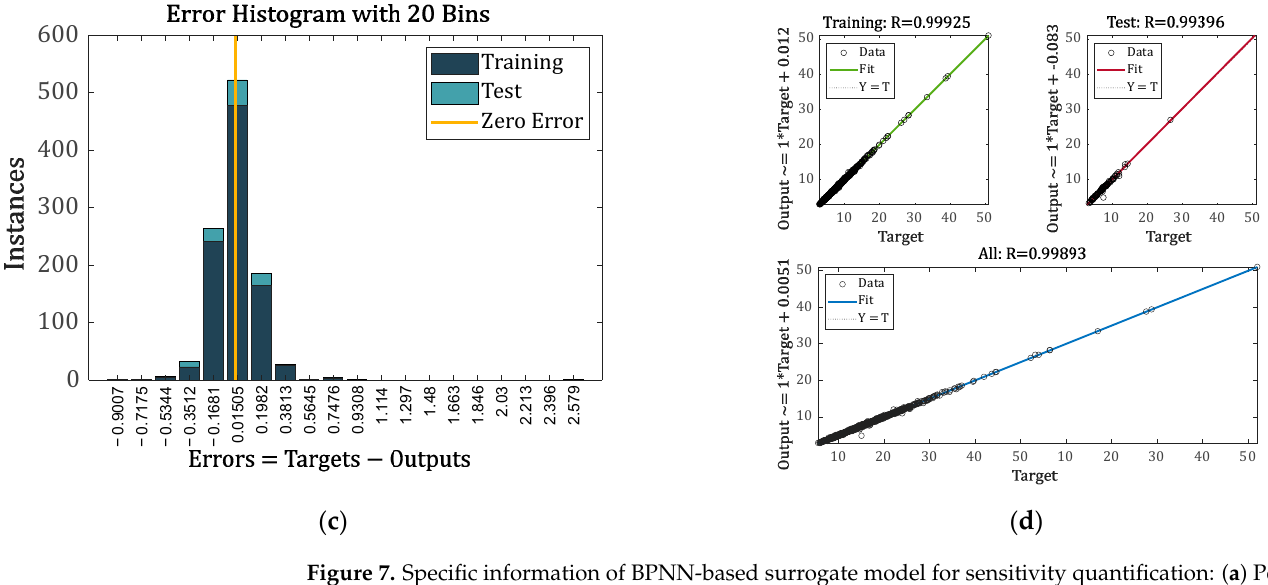
Table 2. The trends of quantities of interest with seven significant variables in the given intervals. Indicators Control Variables